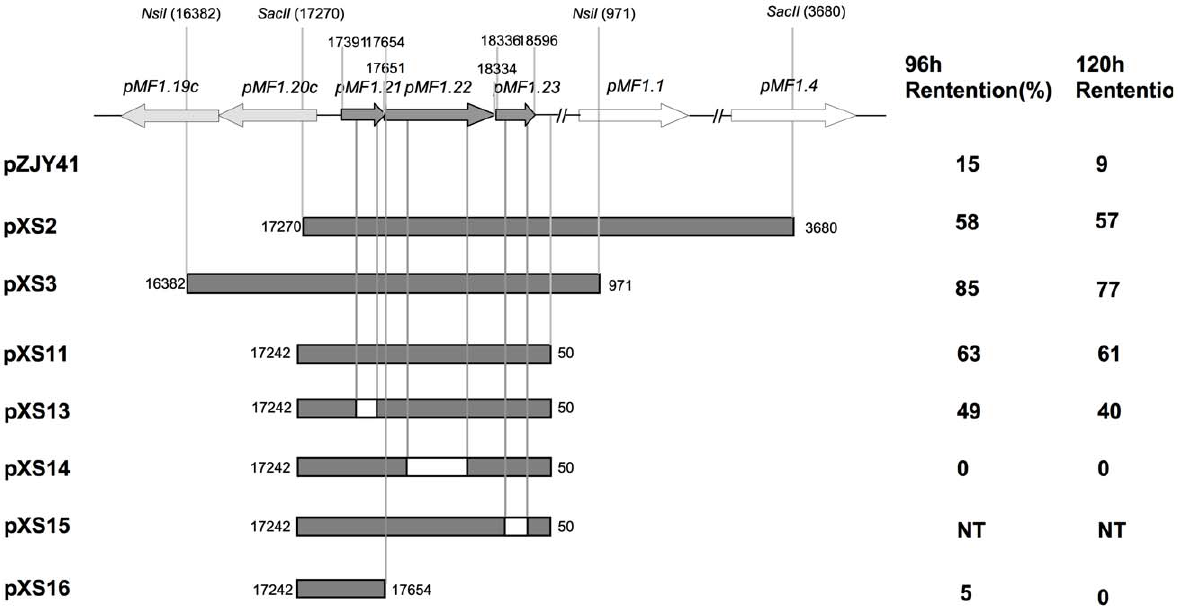
Figure 1. Schematic representation of pXS2, pXS3 and the in-frame deletion regions in pMF1.21 , pMF1.22 and pMF1.23 and their influence on the stability of the plasmids. The white portion within the gray bar stands for the deletion of the corresponding genes in pXS13, pXS14 and pXS15. The corresponding stability of these plasmids in M. xanthus after growth for 96 h and 120 h without selective pressure is indicated on the right. NT, not